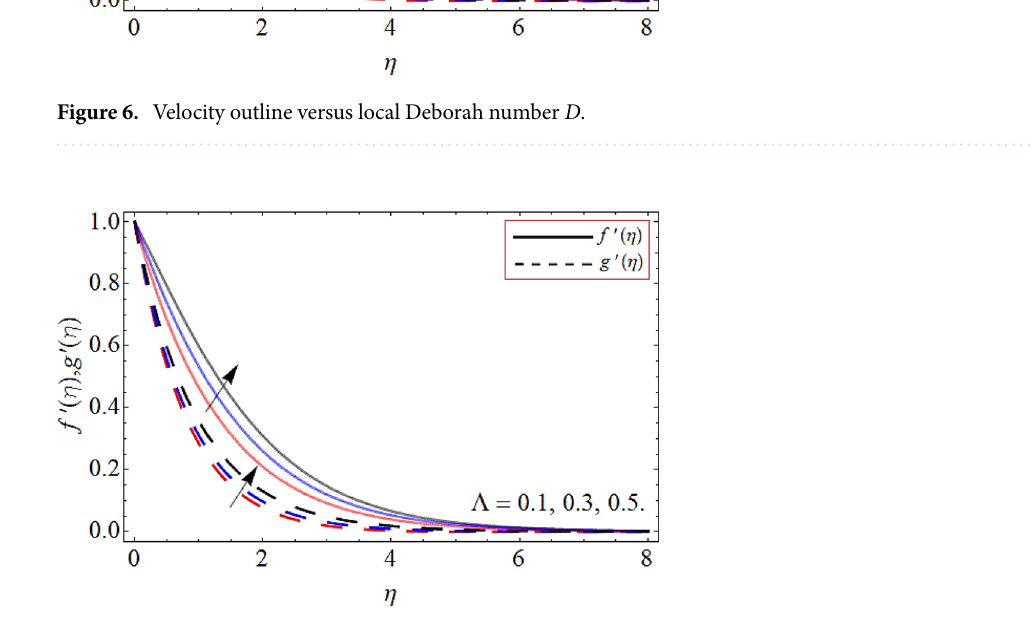
Figure 7. Velocity profile versus wall thickness term (cid:31)